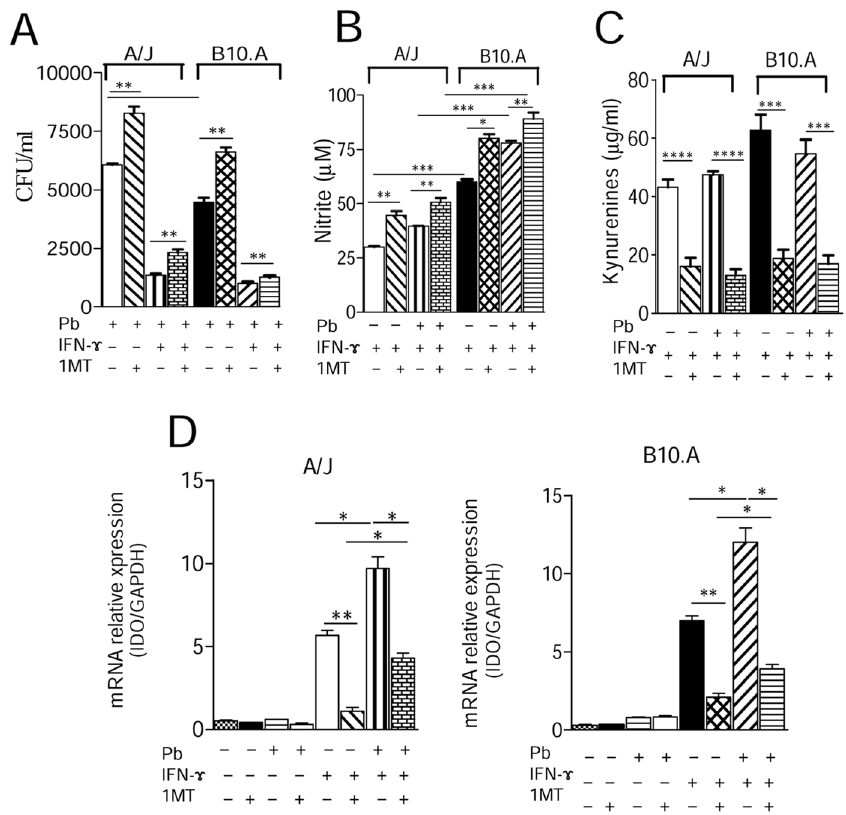
Figure 1. IDO Inhibition increases the fungal loads of macrophages and inhibits kynurenines and IDO mRNA production. ( A ) IFN- c - primed and unprimed peritoneal macrophages from A/J and B10.A mice strains were treated with 1MT (1 mM) or left untreated and subsequently infected with P. brasiliensis yeasts in a macrophage:yeast ratio of 25:1 for 2 h. Infected and uninfected macrophages were then cultivated for 48 h at 37 u C in 5% CO2. The monolayers were lysed with distilled water, and 100 m l of cell homogenates were assayed for the presence of viable yeasts by a CFU assay. ( B, C ) Supernatants from macrophage cultures were used to determine the levels of nitrite and kynurenines. ( D ) In the same experimental conditions, peritoneal macrophages of A/J and B10.A mice were mixed with TRizol reagent for RNA extraction and then submitted to qRT-PCR assays for mRNA IDO evaluation ( D ). Data are the means 6 SEM of quintuplicate samples from one experiment representative of 3 independent determinations (* p , 0.05, ** p , 0.01, *** p , 0.001 and **** p , 0.0001).